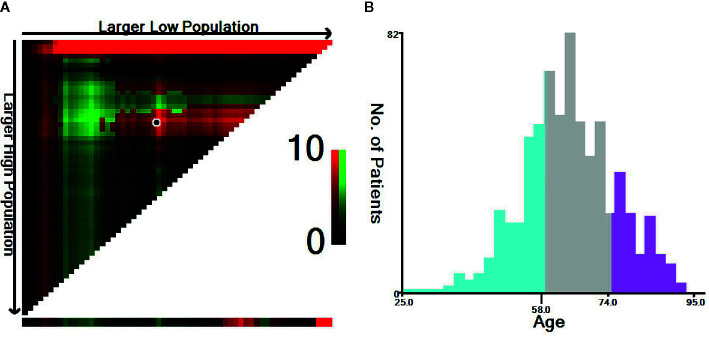
Identification of the optimal age cut-off points for esophageal cancer patients with lung metastasis. (A) X-tile plots based on age according to esophageal cancer-specific mortality. The plots show χ2 log-rank values; the brightest pixel represents the maximum χ2 log-rank value. (B) Distribution of patients according to age ranging from 25 to 95 years old. The optimal age cut-off of ECLM patients age is shown as 58 and 74 years old (χ2 = 9.65, P < 0.001).